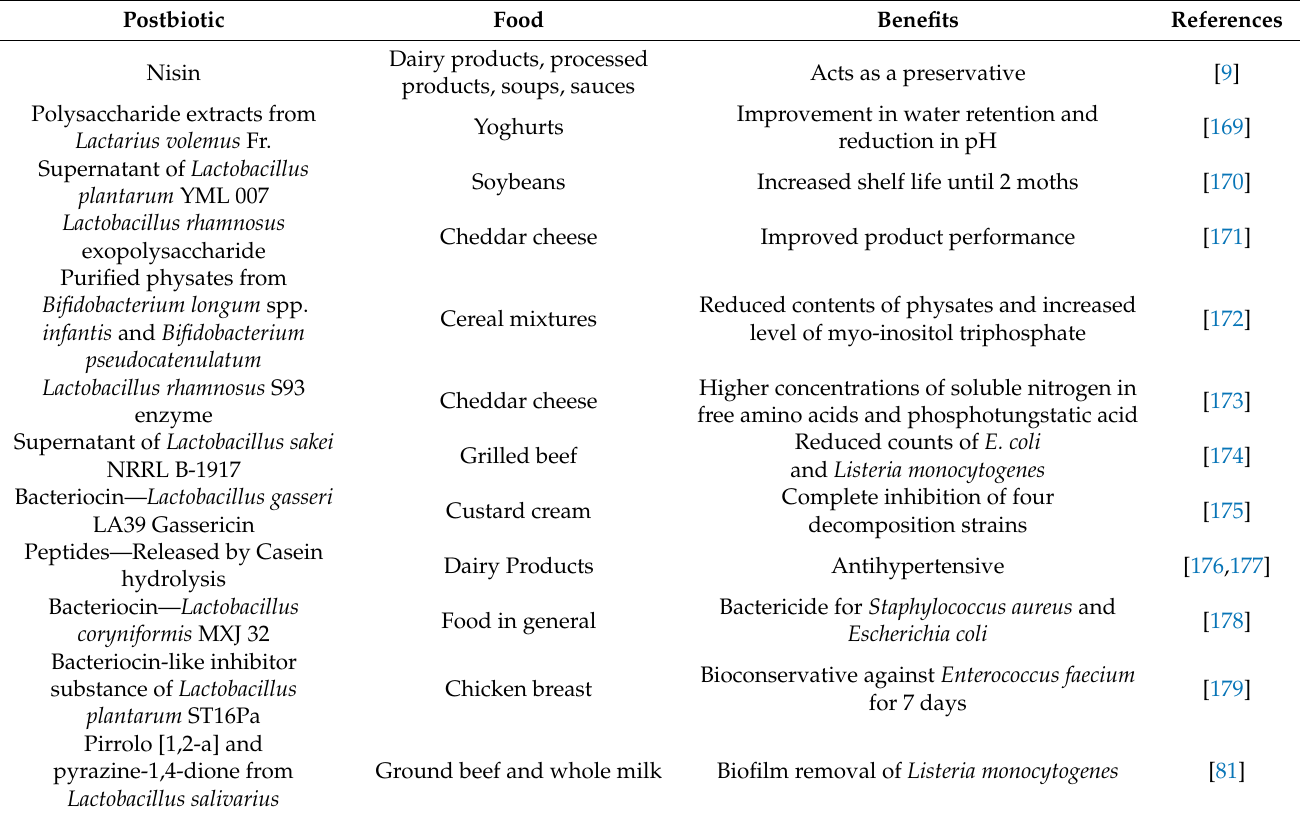
Table 3. Application and benefits of postbiotics in food